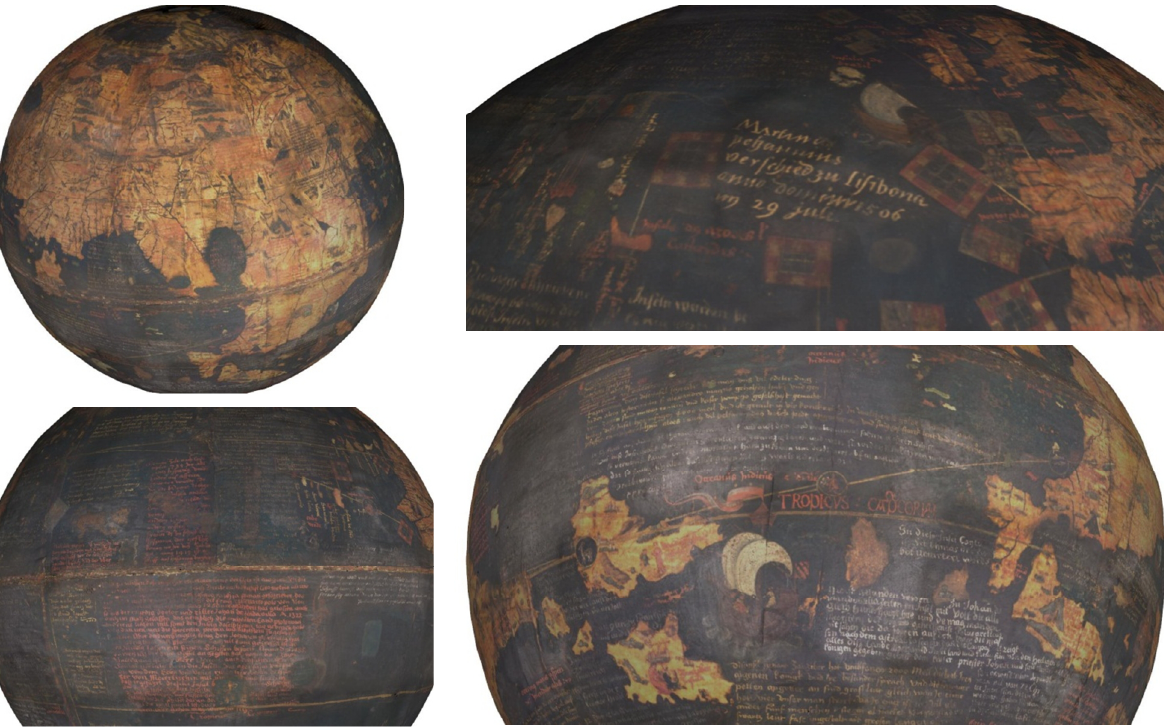
Fig. 6: The textured model of the globe with some closer views of the illustrations and legends.